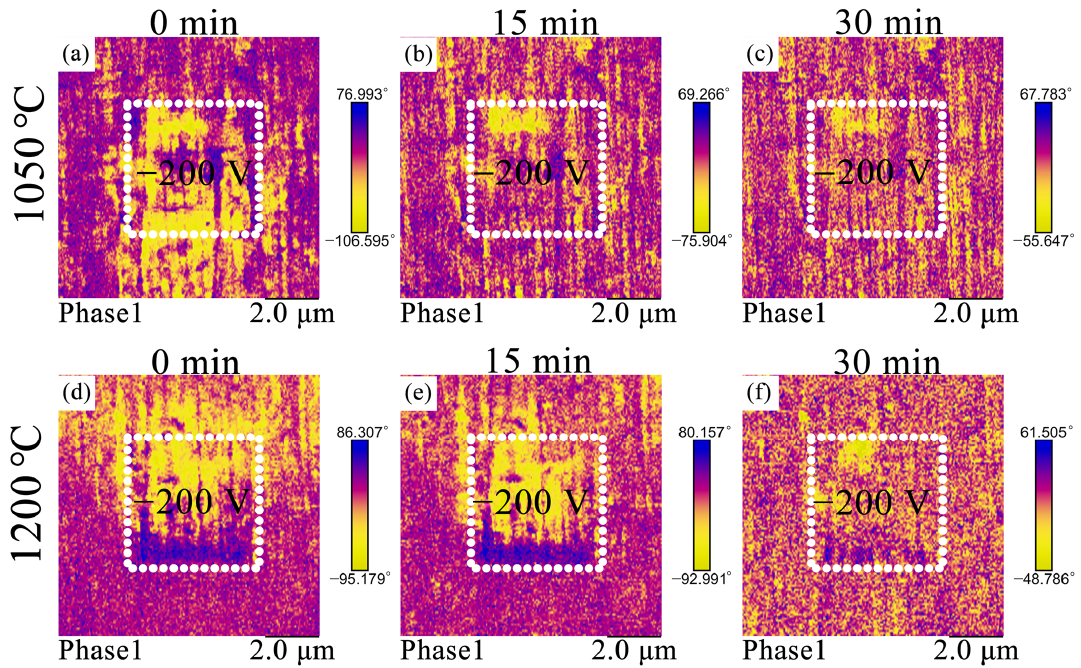
Figure 7. PFM image of NBT-BT-NN ceramics at different sintering temperatures ( a – c ) 1050 °C, ( d – f ) 1200 °C.